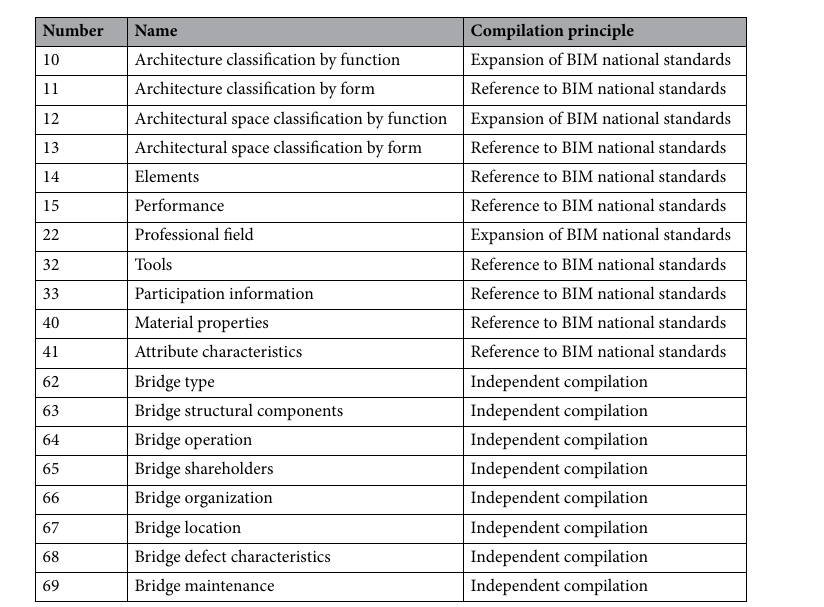
Table 2. Bridge defect data classification coding based on the IFD